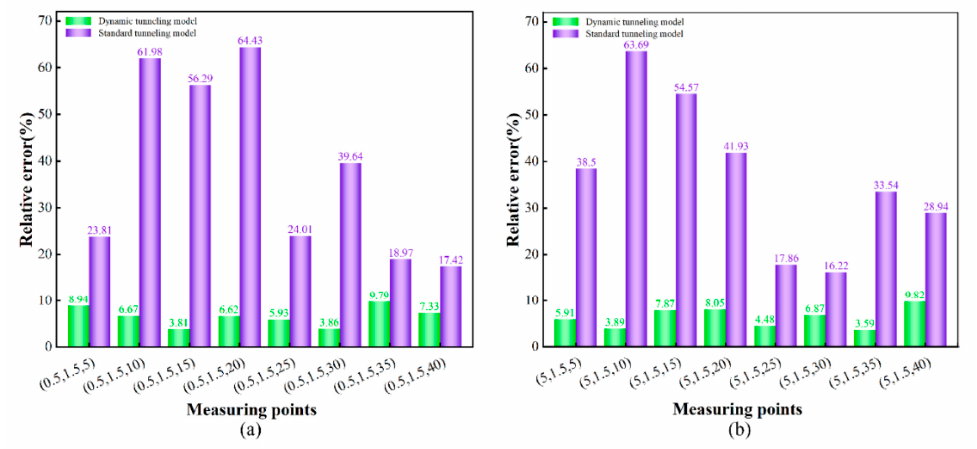
Figure 22. Relative errors of dust under different conditions.